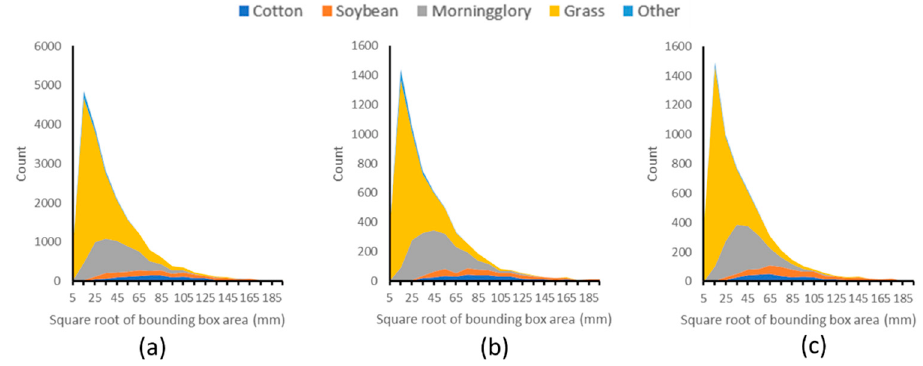
Figure 6. Plant composition and bounding box size distribution of the annotated images for the three lighting conditions: ( a ) sunny around noon, ( b ) sunny around sunset, and ( c ) cloudy.